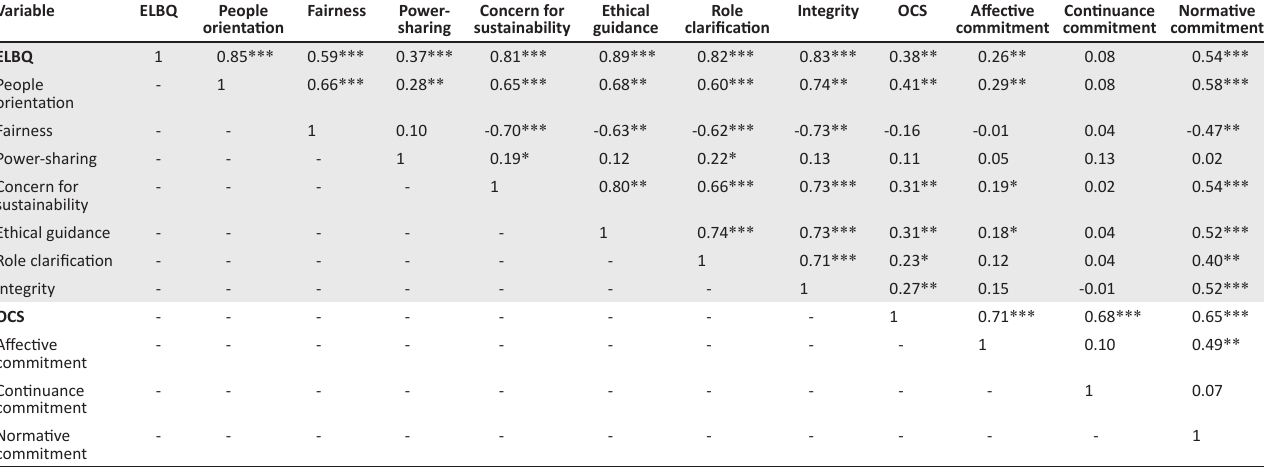
TABLE 2: Correlations between the Ethical Leadership Behaviour Questionnaire and Organisational Commitment Scale ( N = 130). Variable ELBQ